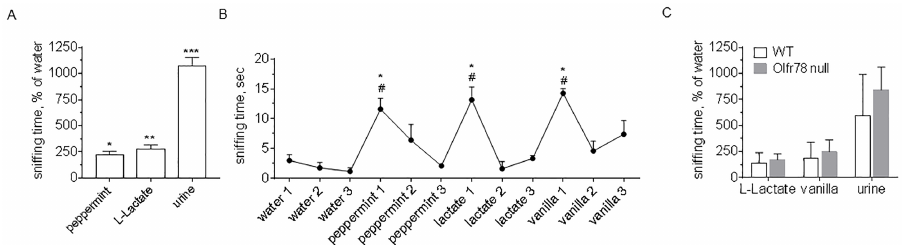
Fig 1. Mice are able to detect and discriminate the odour of L-Lactate. A. Odour detection task . Mice spent significantly more time sniffing L-Lactate (1M) than water, and the same amount of time as peppermint extract. Data are shown as mean ± SEM, n = 8. * p < 0.05, ** p < 0.01, *** p < 0.001vs water, paired t-test. B. Odour habituation-dishabituation test . On the first presentation, mice spent significantly more time sniffing L-Lactatein comparisonto water and to the third introduction of the previousodour (peppermint). Over severalintroductionsmice habituatedto the smell of L-Lactateand sniffed it for shorter times duringthe third introduction comparedto the first Data are shown as mean ± SEM, n = 3. # p < 0.05vs third introductionof previous odour, * p < 0.05vs first water introduction,pairedt-test. C. Odour detection task in Olfr78 null mice . Olfr78 null mice spent the same amount of time as control littermates sniffing L-Lactate (2M), or control smells–vanillaand urine of the oppositegender. Data are shown as mean ± SEM,n Olfr78 null = 7, n WT =